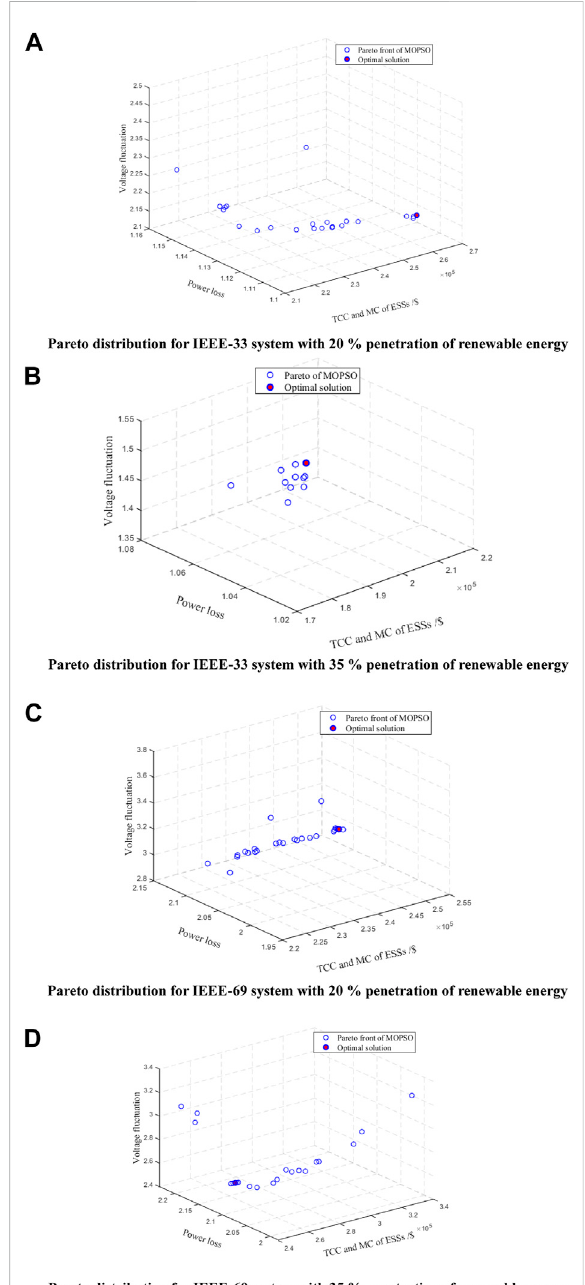
FIGURE 8 The pareto front of MOPSO and the position of the optimal solution. (A) Pareto distribution for IEEE-33 system with 20 % penetration of renewable energy; (B) Pareto distribution for IEEE- 33 system with 35 % penetration of renewable energy; (C) Pareto distribution for IEEE-69 system with 20 % penetration of renewable energy; (D) Pareto distribution for IEEE-69 system with 35 % penetration of renewable